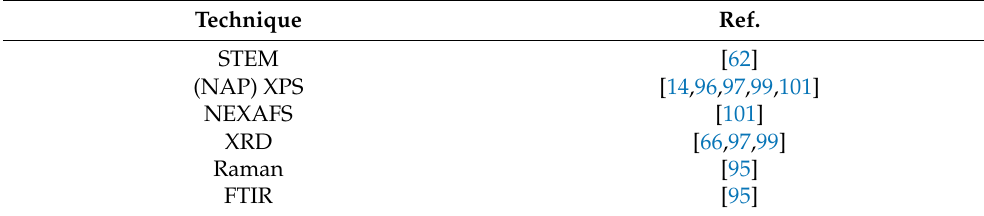
Table 1. Summary of the in situ techniques used for MoVNbTeO x